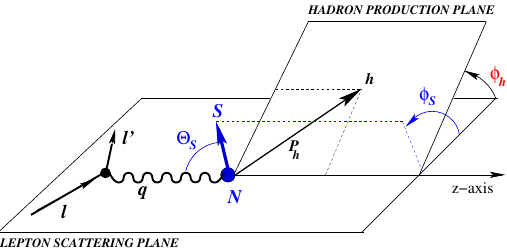
Figure 1. Kinematics of the SIDIS process lN ! l 0 hX in the 1-photon exchange approximation.